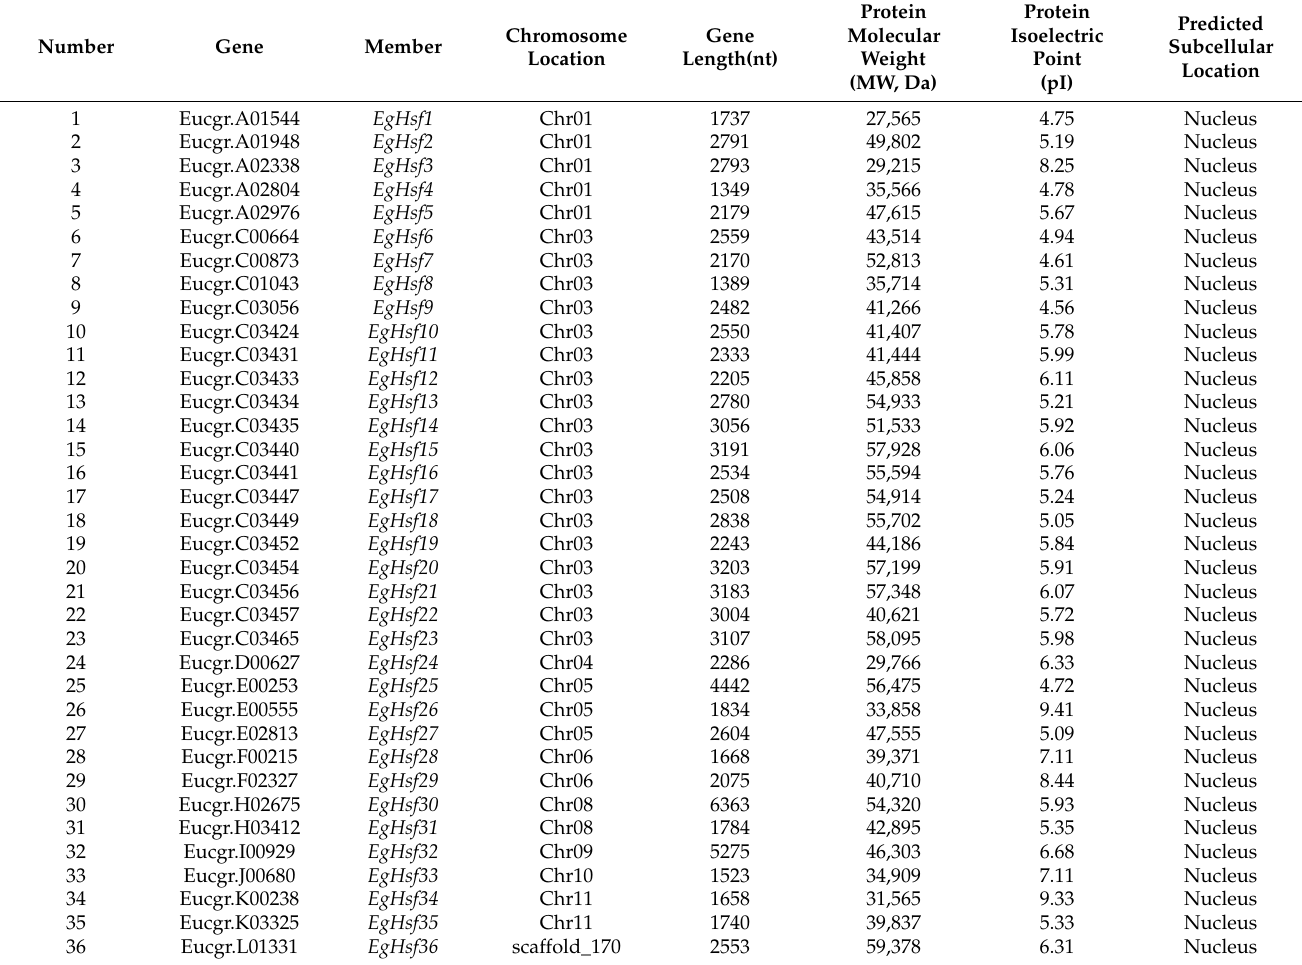
Table 1. Detailed information on 36 EgHsf genes of Eucalyptus and their encoded